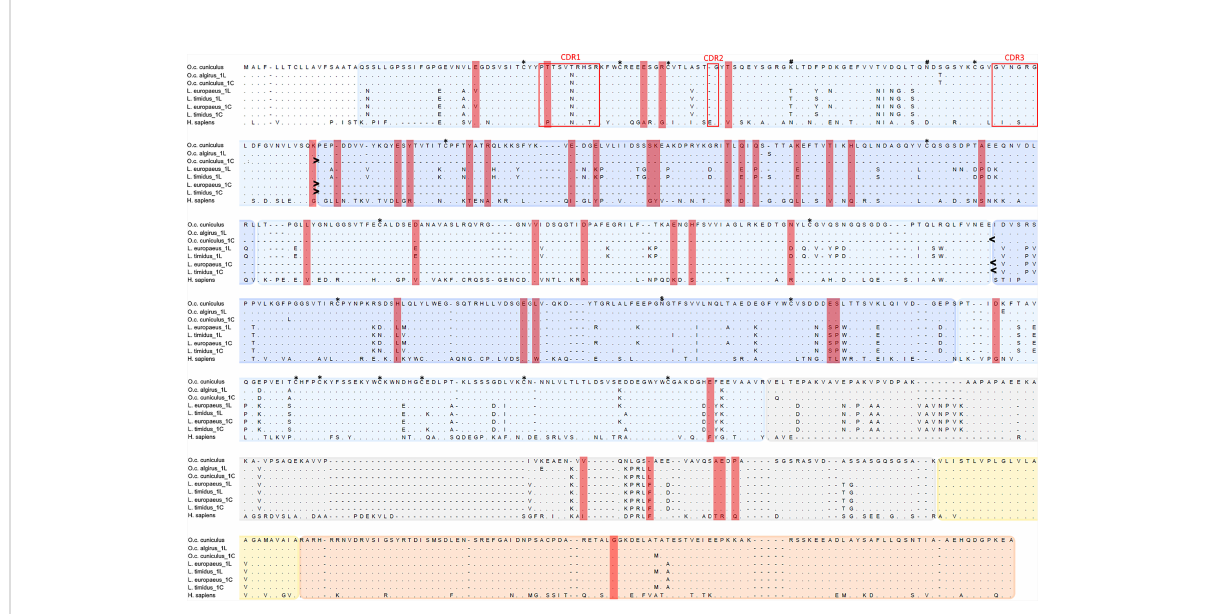
FIGURE 2 Alignment of leporid and human pIgR amino acid sequences. Shown are the pIgR amino acid sequences for the two European rabbit subspecies ( O.c. cuniculus and O.c. algirus ), the two studied hare species ( L. europaeus and L. timidus ) and Human ( H. sapiens ); for leporids, 1L identi fi es the long isoform and 1C the short isoform. The deletion of Ig like domains 2 and 3 in the leporids short isoforms is indicated between > and <. The PSC ’ s identi fi ed for the mammalian pIgR are highlighted in red rectangles. Protein domains are shaded in different colors: Ig like domains in two alternating blue accents, the linker spacer in grey, the transmembrane domain in yellow and the cytoplasmic tail in orange. The Ig like domain 1 CDRs are within red boxes. Conserved Cys residues are marked with * above the alignment. N-glycosilation sites are marked above the alignment: # indicates European rabbit glycosylation sites (51) and $ shows the rabbit and hare glycosylation